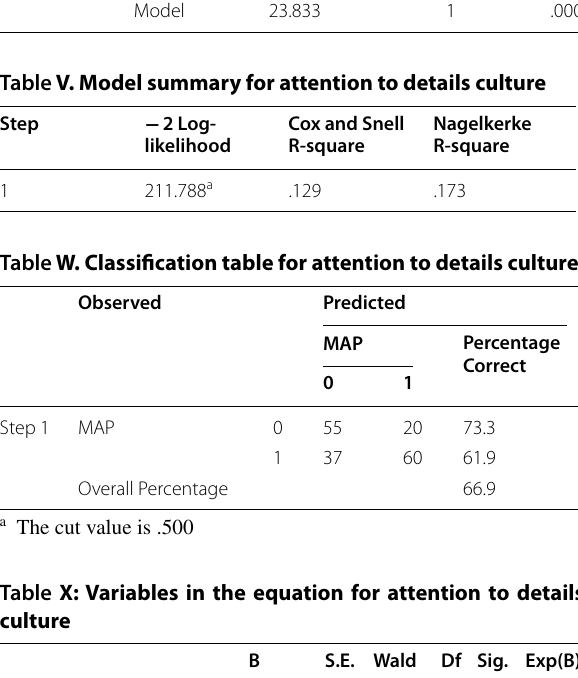
Table Y: Omnibus tests of model coefficients for a teamwork culture